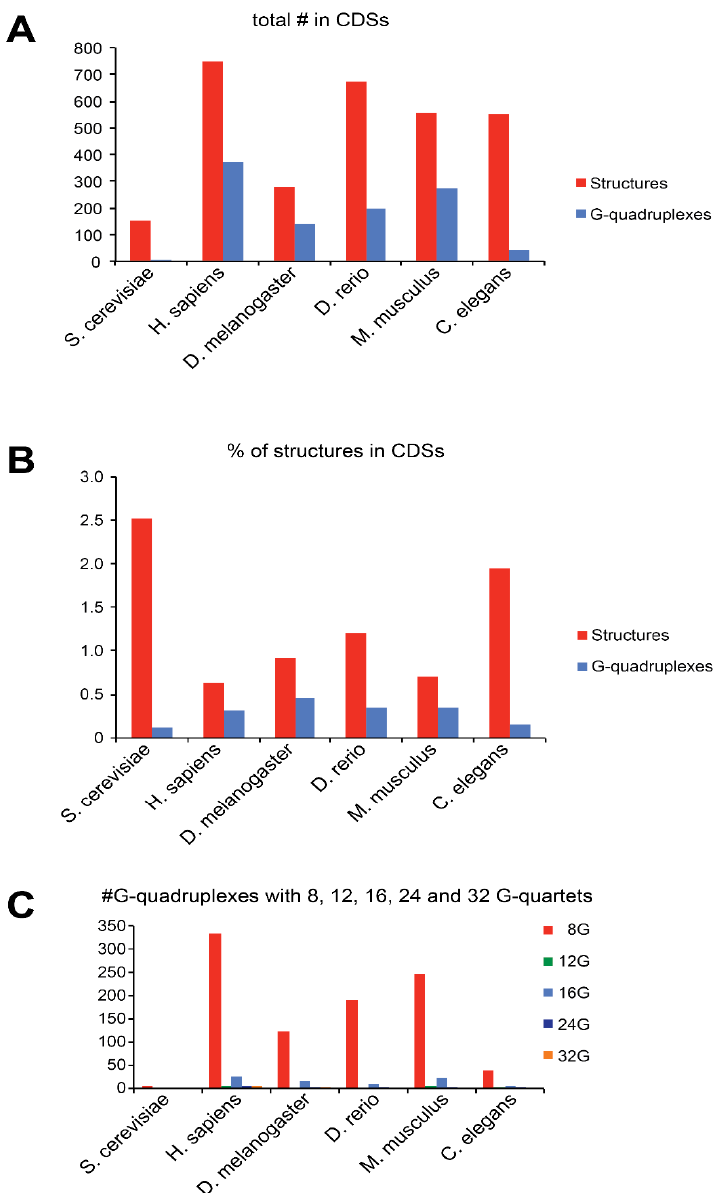
Figure 2. ( A ) The histogram represents the total number of putative secondary structures (red) and G-quadruplexes (blue) found in the + 16 to + 65 window of CDS that have a MFE struc / MFE rand ratio of at least 2 in the CDSs from six eukaryotes. ( B ) The histogram represents the percentage of CDSs that contained secondary putative structures (red) and G-quadruplexes (blue). ( C ) The histogram represents the number of G-quadruplexes with 8, 12, 16, 24 and 32 G-residues in each organism. We performed the same analysis on prokaryotic species. We screened the coding sequences from four Gram-positive bacteria and four Gram-negative bacteria (Supplementary Tables S1,S3). In